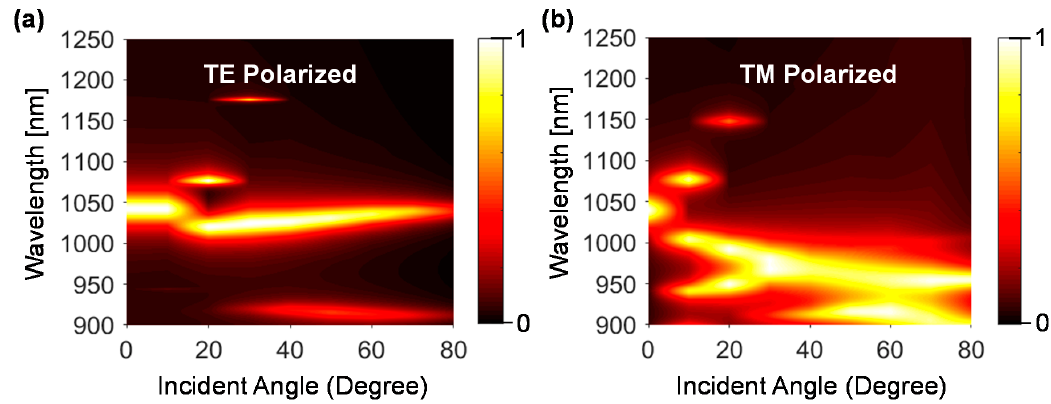
Figure 6. Angular dispersions of the absorbance peak for ( a ) TE and ( b ) TM polarized mode.